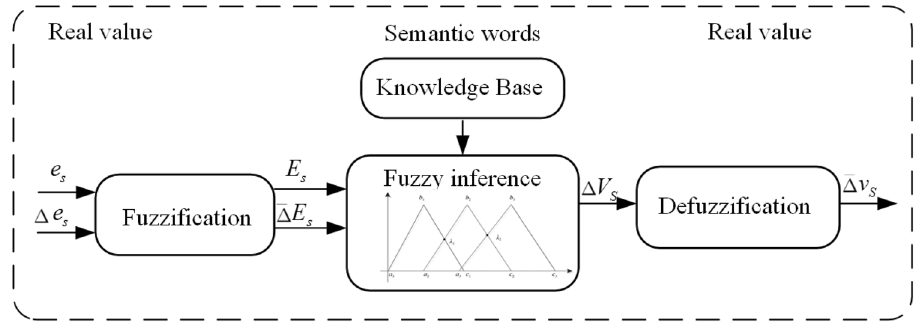
Figure 6. Compensated control based on fuzzy